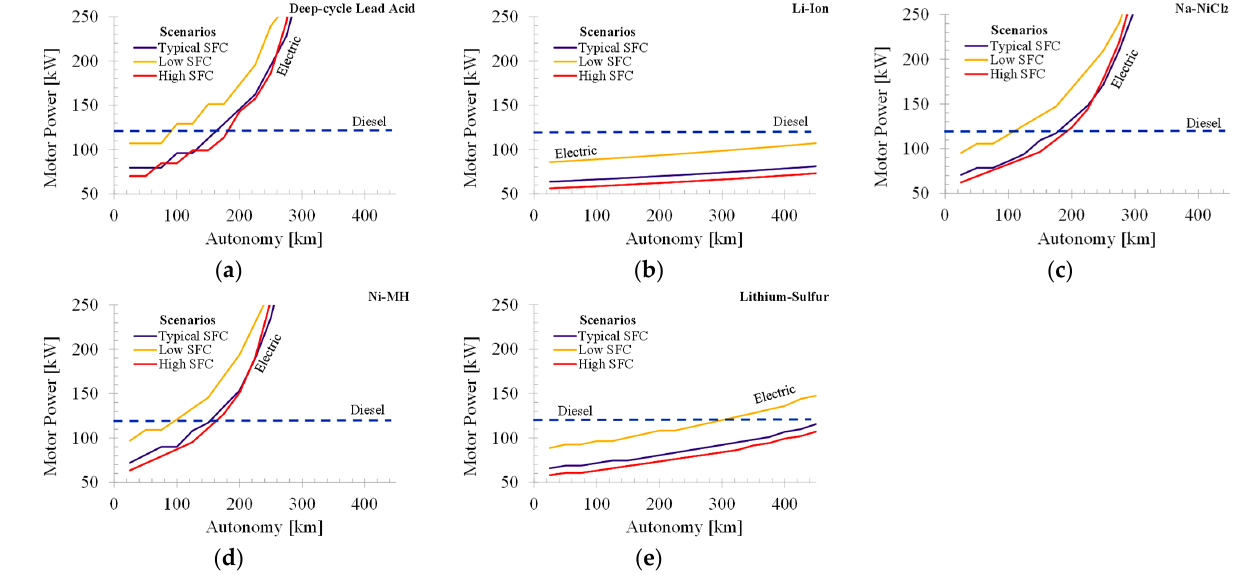
Figure A3. Impact of the desired minimum autonomy on the minimum motor power required considering ( a ) deep-cycle lead acid, ( b ) Li-Ion, ( c ) Na-NiCl 2 , ( d ) Ni-MH, and ( e ) lithium-sulfur batteries for low SFC, typical SFC, and high SFC scenarios.